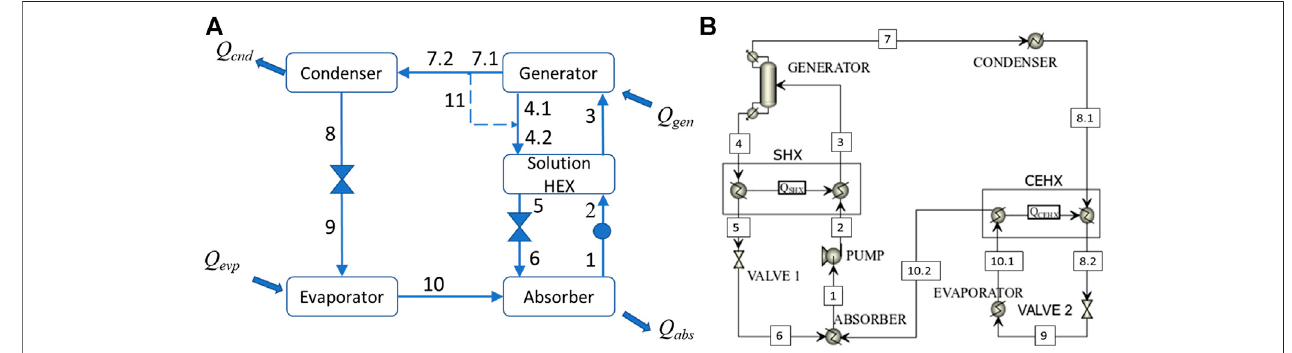
FIGURE 3 | (A) The conceptual ABR model used in the course of CAMD in Stage 1, (B) the complete ABR model used in Stage 2. The dashed line representing stream 11 is used to explain the calculations made in the model of case (A) and is not a real process stream.